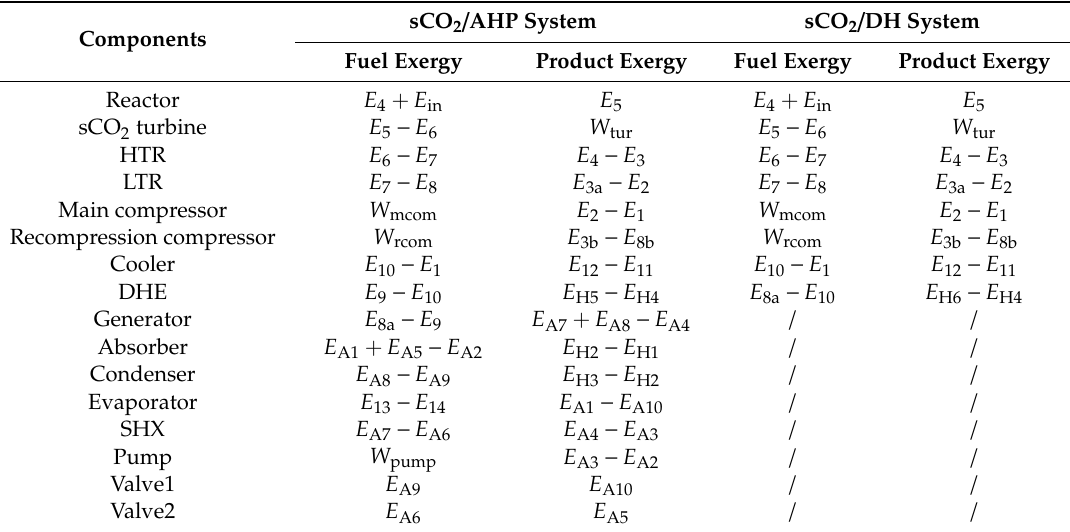
Table 2. Fuel-product definitions for the combined